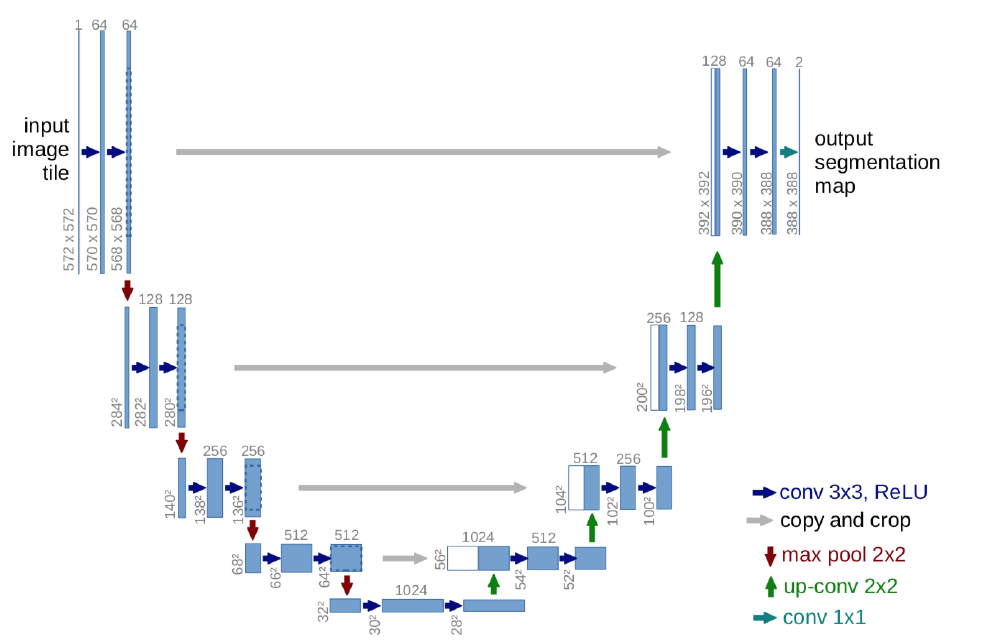
Figure 2. UNet architecture proposed by Ronneberger et al. [7]. It consists of an encoder part that extracts the complex low-level features by reducing the image dimensions and increasing the number of channels. The decoder part upsamples the low-level features and maps the high-level features to output, which is a semantic segmentation mask containing the desired number of classes, i.e., five in our